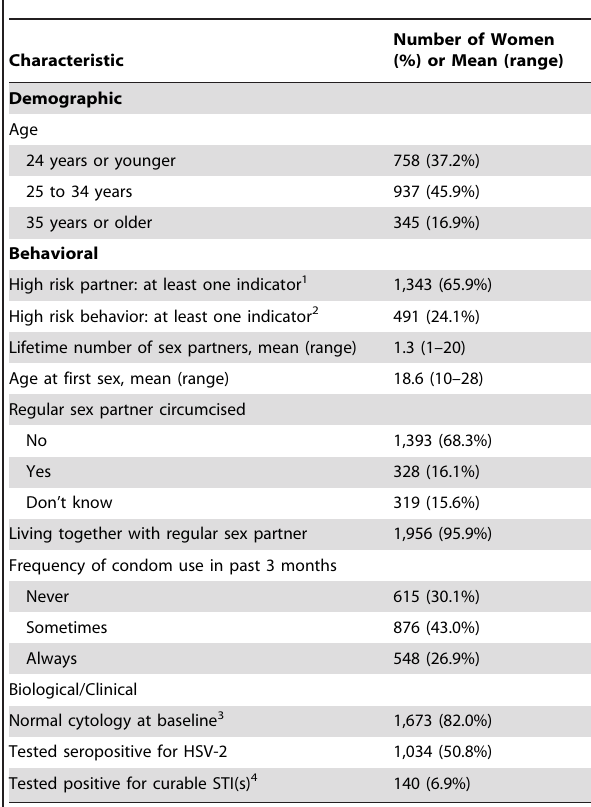
Table 1. Demographic, behavioral, and biological/clinical characteristics of participants at baseline (N=